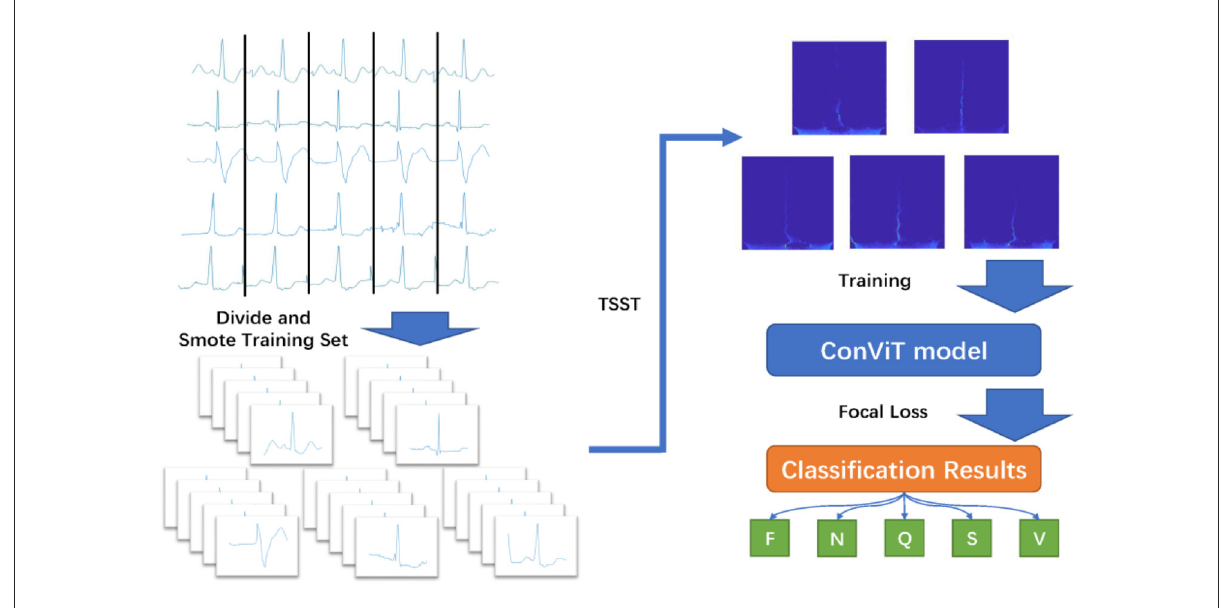
FIGURE1 Flow chart of ECG classification based on TSST and ConViT.